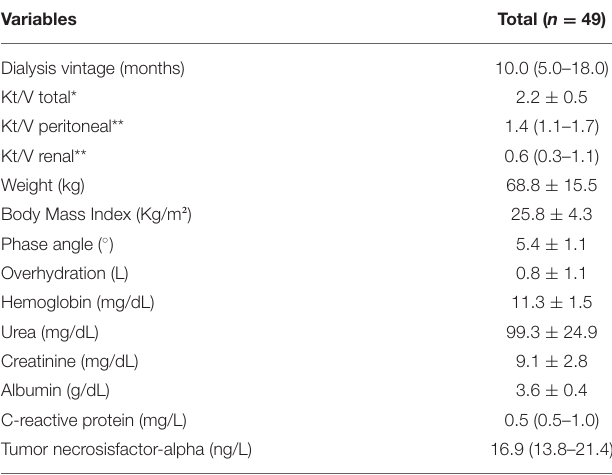
TABLE 1 | Clinical and nutritional characteristics of PD